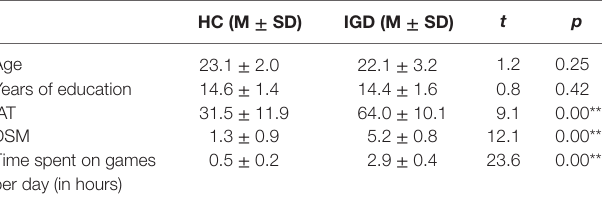
Table 1 | Demographic characteristics for HC and IGD participants.